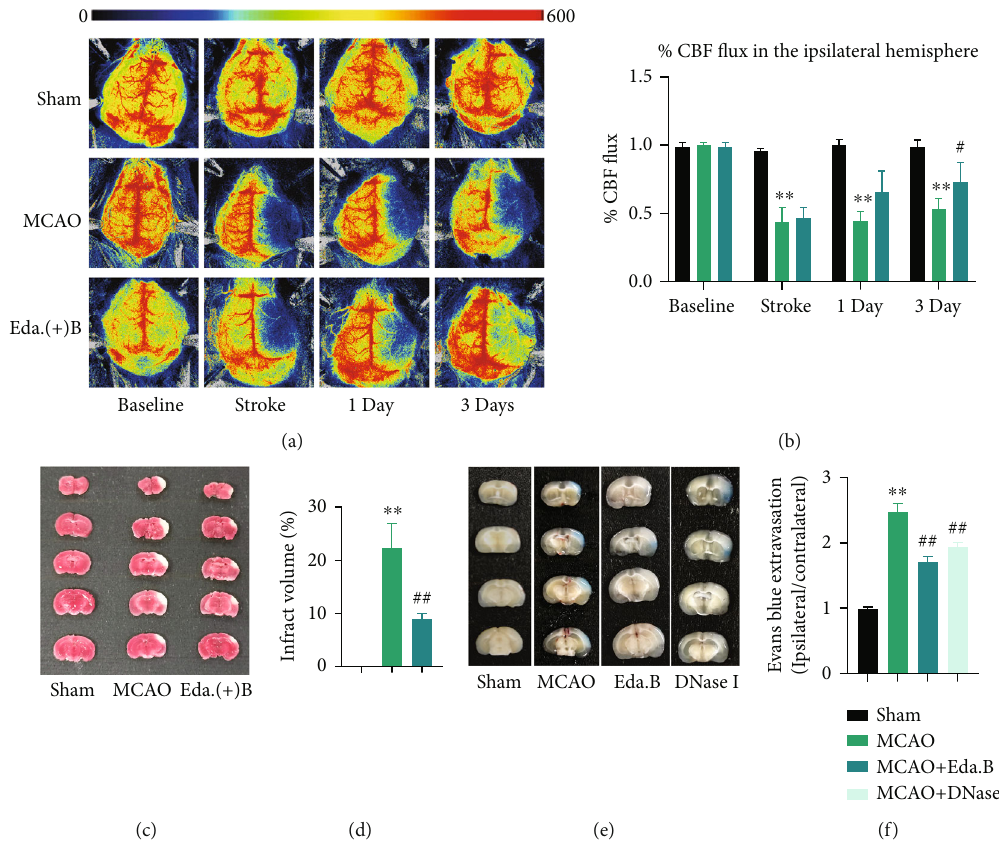
Figure 3: Protective e ff ects of Eda.B on MCAO mice in cerebral blood fl ow (CBF), TTC-stained, and Evans blue leakage. (a) Representative perfusion images of CBF at baseline, 5min (stroke), day 1, and day 3 after MCAO. (b) The percent CBF fl ux (%) in the ipsilateral hemisphere was shown at di ff erent time points. (c, d) Representative TTC-stained brain sections and quantitatively infarct volume in Sham group, MCAO group, and Eda.B group at day 3 after stroke. (e, f) Representative images and quanti fi cation data of Evans blue leakage in the brain in Sham group, MCAO group, Eda.B group, and DNase I group at day 3 after stroke. ∗∗ P < 0 : 01 (MCAO group vs. Sham group), # P < 0 : 05 (Eda.B group vs. MCAO group), and ## P < 0 : 01 (Eda.B group or DNase I group vs. MCAO group), n = 4 in each